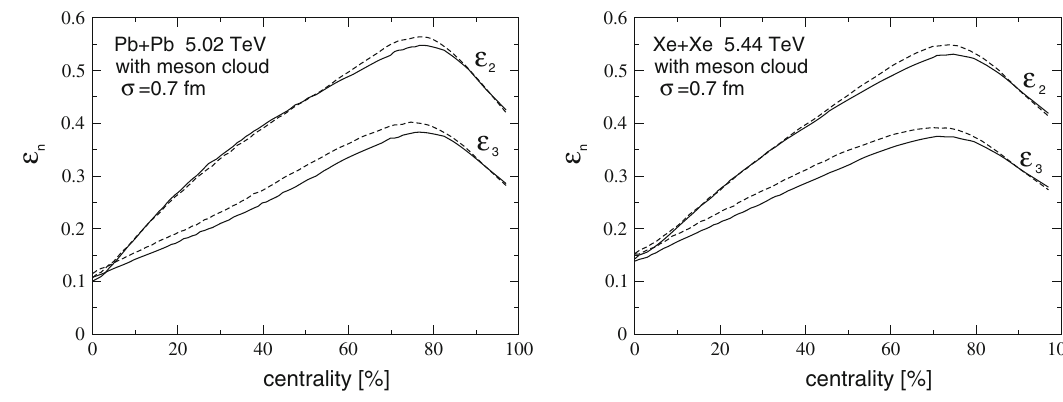
Fig. 6 Centralitydependenceoftherms ε 2 , 3 fortheversionwithmeson cloud with the Gaussian source distribution (8) for σ = 0 . 7 fm in Pb √ s = 5 . 02 TeV (left) and in Xe + Xe collisions at + Pb collisions at